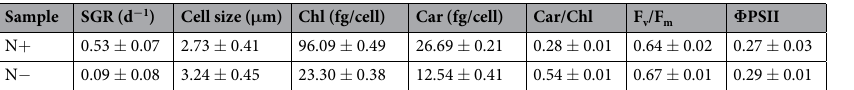
Table 1. Changes in specific growth rate (SGR), cell size, chlorophyll a (Chl) and total carotenoid (Car) contents, maximal (F v /F m ), and effective quantum yield of photosystem II ( Φ PSII) in darkness and during illumination in N. salina cells grown under nitrogen-rich (N + ) and nitrogen-depleted (N − ) conditions for 2 days. Data are expressed as the average of three biological replicates ± SD. Each sample was significantly different from the other (independent two-tailed t -test, p -value < 0.05). Cell size was measured from TEM